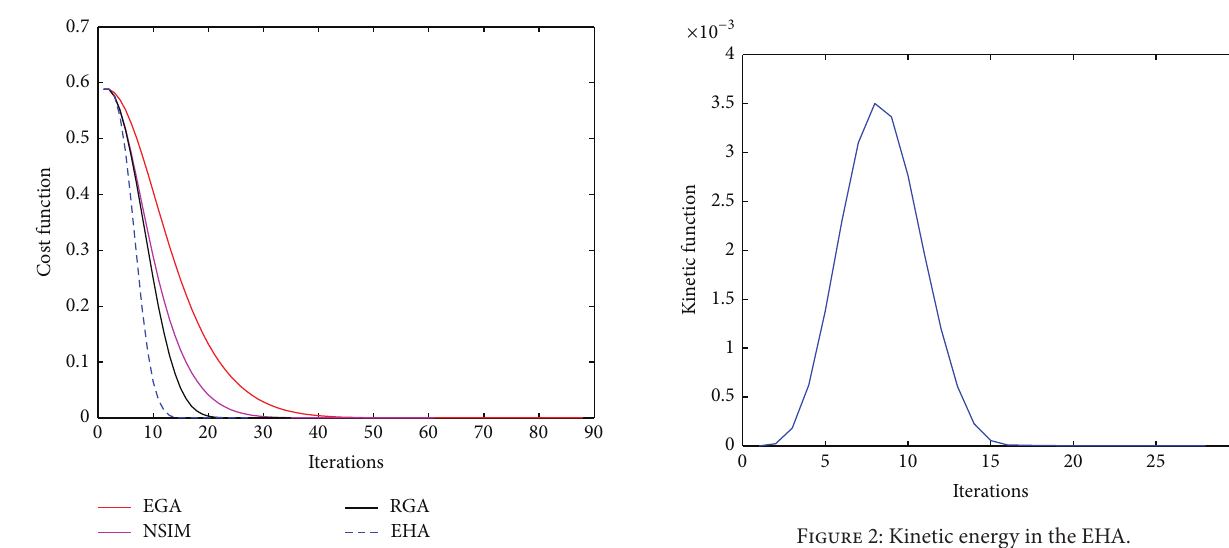
Figure 1: Comparison of convergence speeds of the EGA, the RGA, the NSIM, and the EHA.